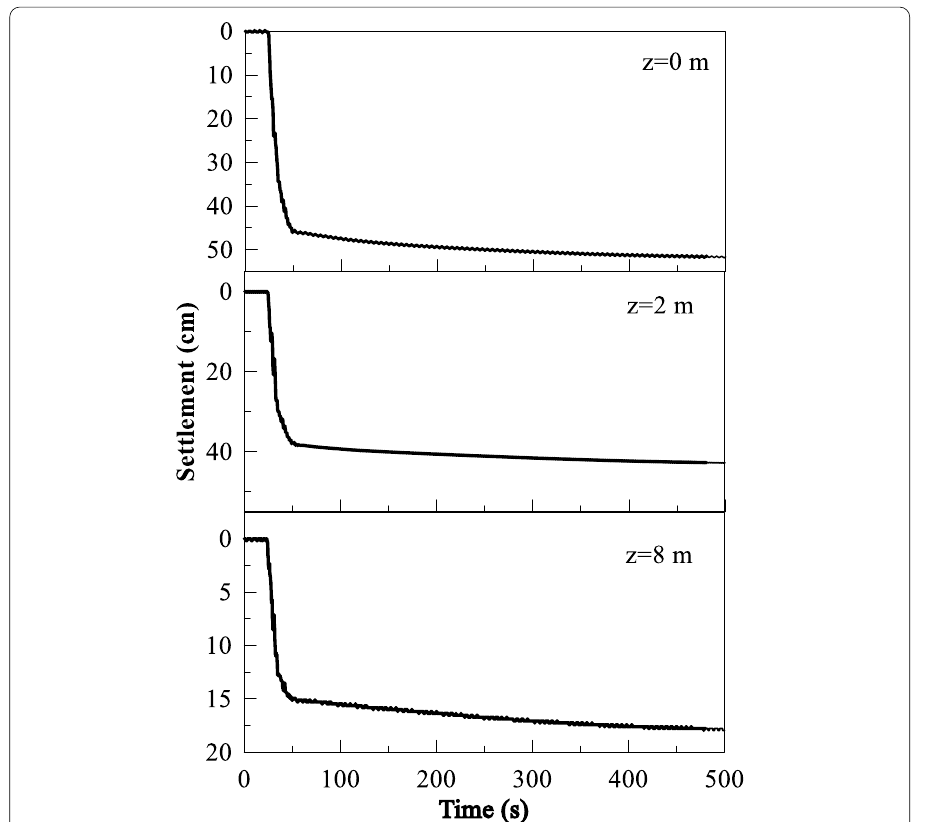
Fig. 4 The measured settlement histories at different depths during the Kobe‑L